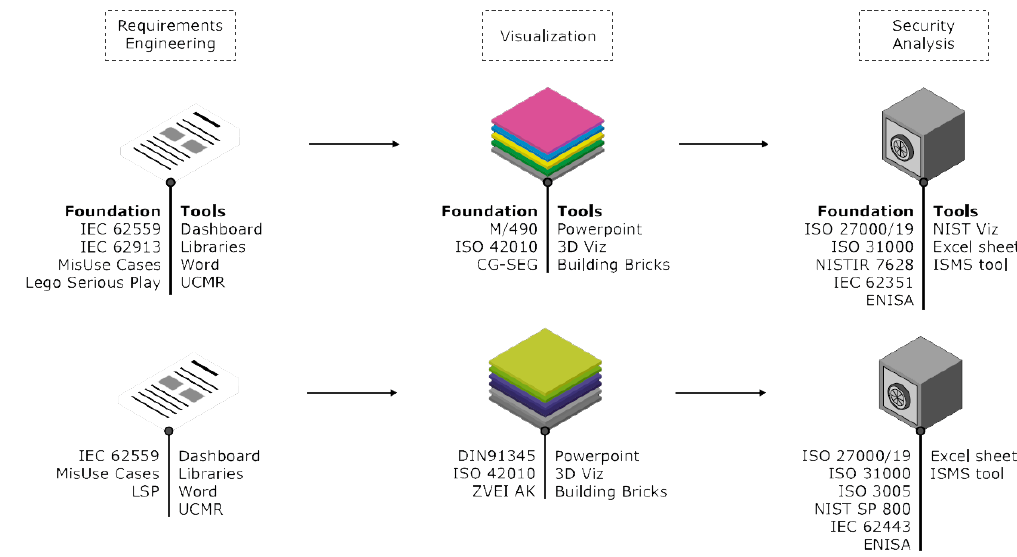
Figure 14. RAMI 4.0 vs. SGAM tooling